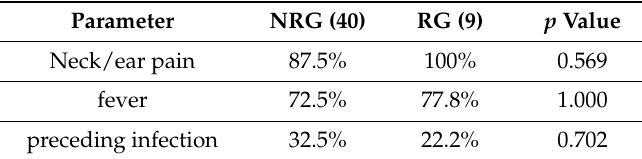
Table 2. Comparison of the clinical features in the non-recurrence (NRG) and recurrence (RG) groups. Parameter NRG (40) RG (9) p Value Neck/ear pain